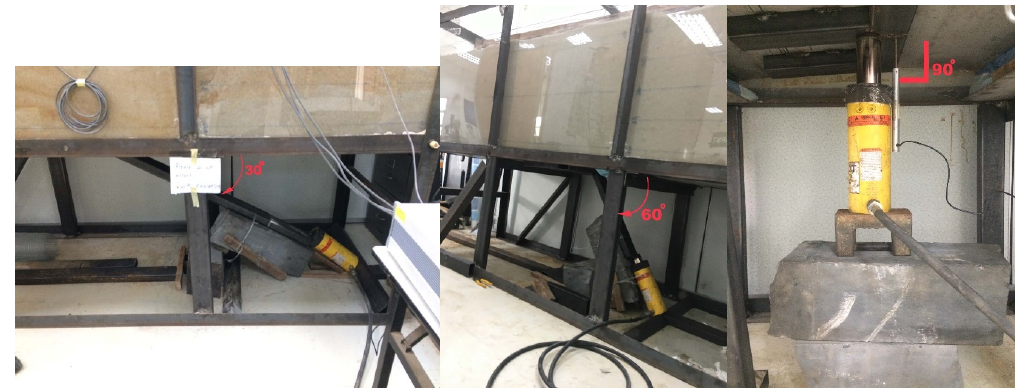
Figure 3. Illustration of fault angles of 30°, 60°, and 90°. Table 7. Soil properties used for various tunnel depths.